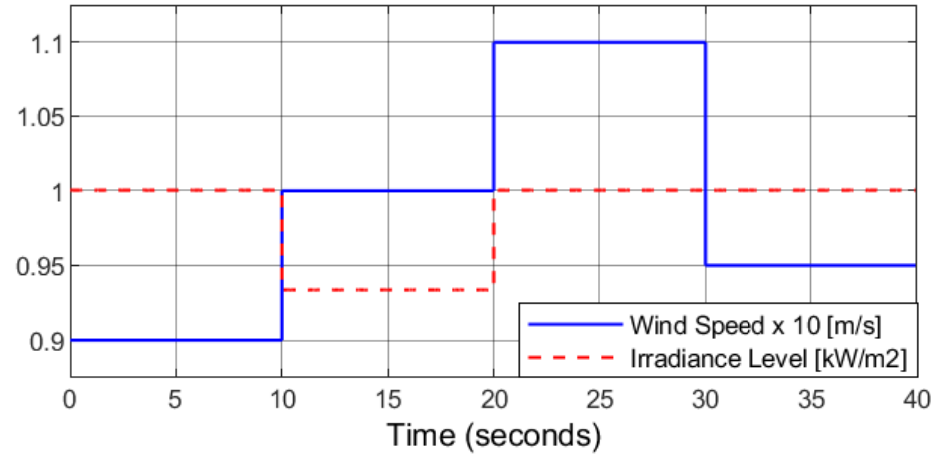
Figure 2. Irradiance level in Scenario 1 and wind speed in Scenario 2.